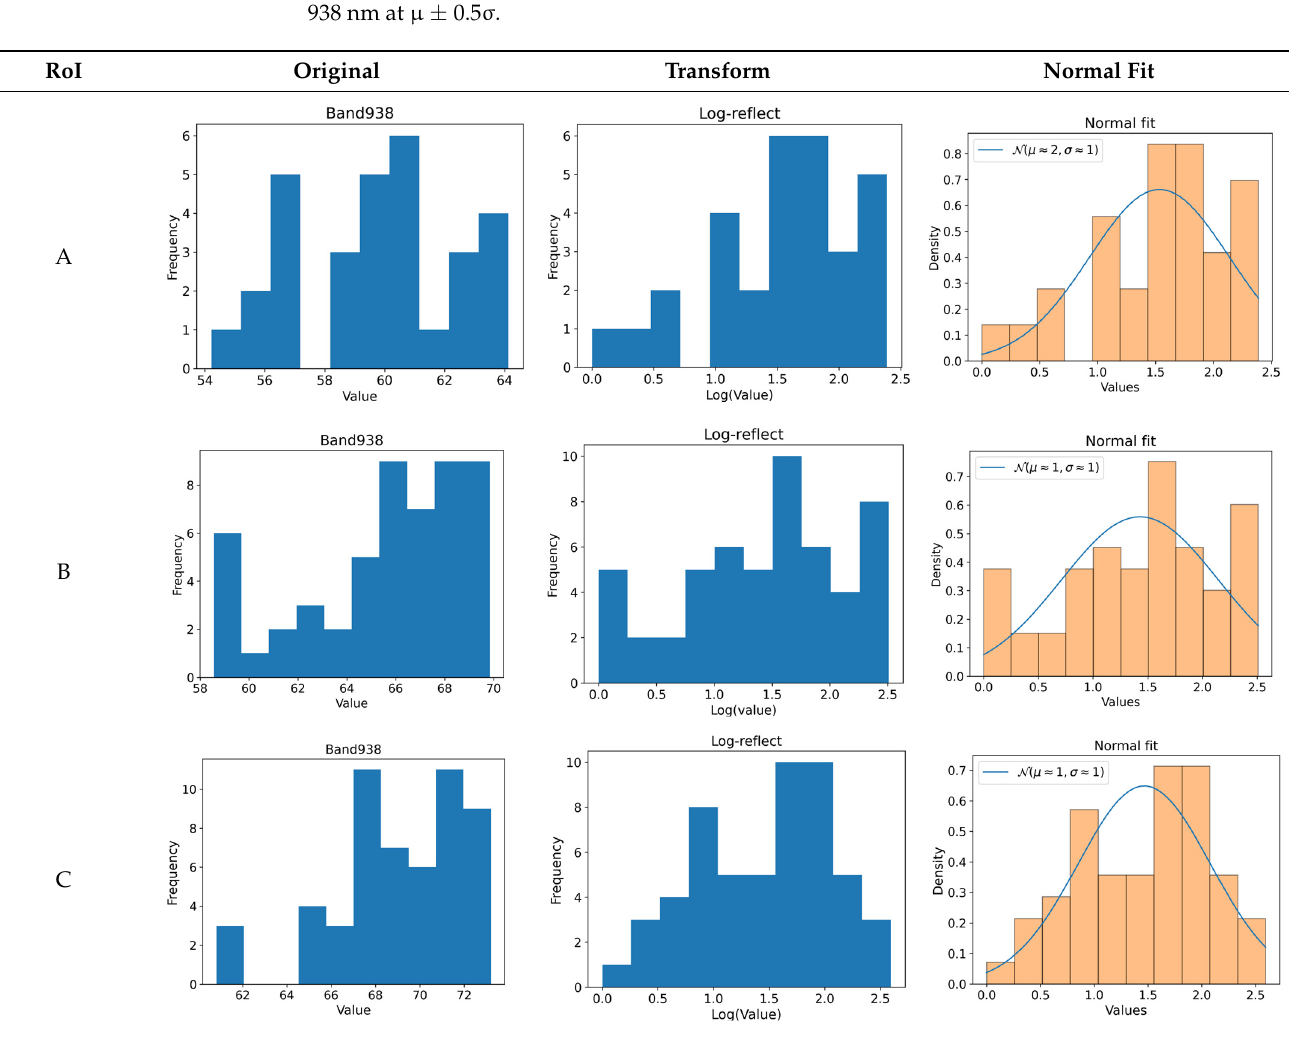
Table 2. Data distribution of the original and transformed data for the RoIs A, B and C at wavelength 938 nm at µ ± 0.5 σ .